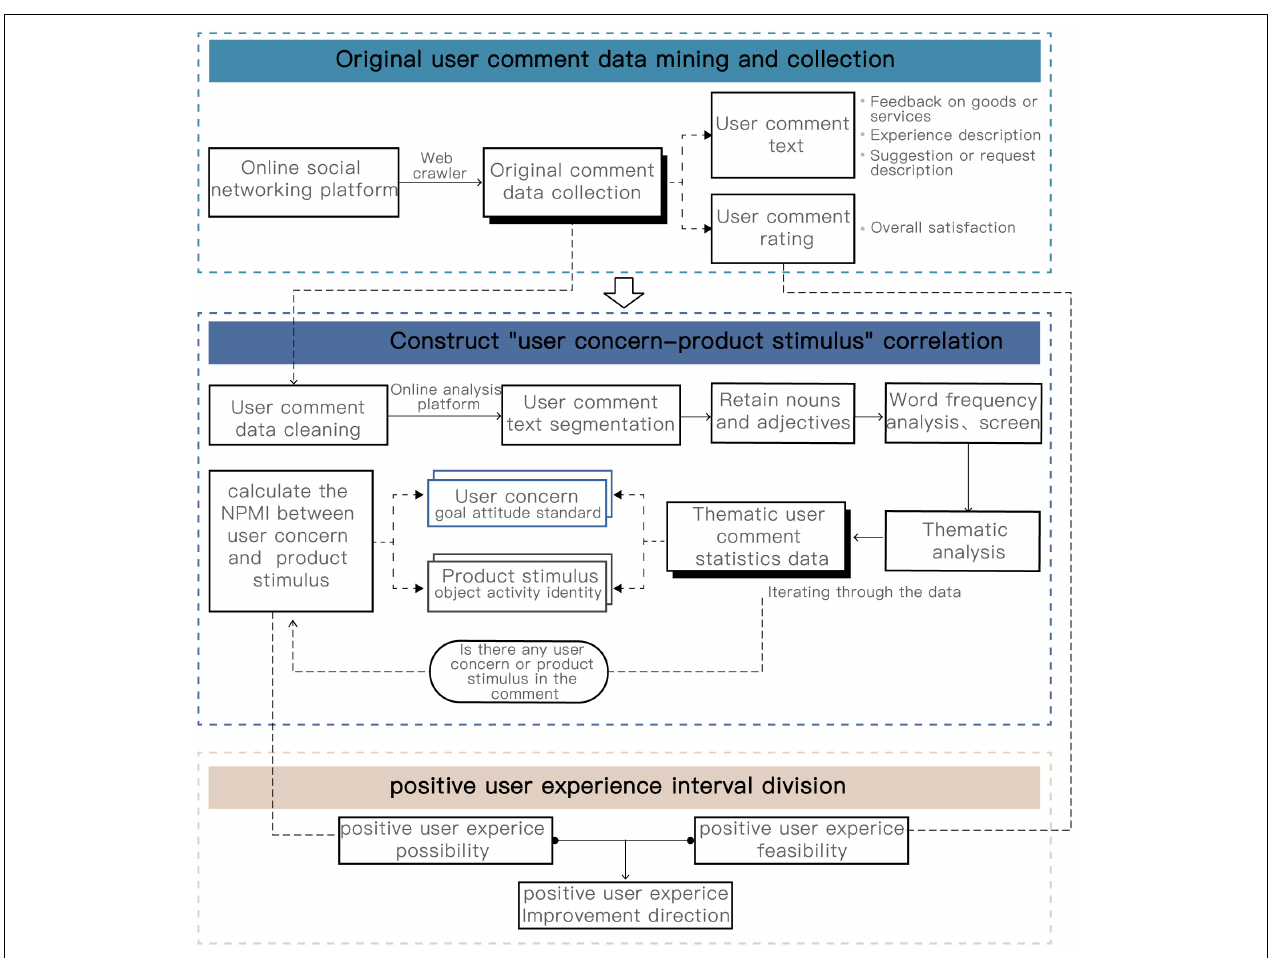
FIGURE 2 | Positive user experience design exploration